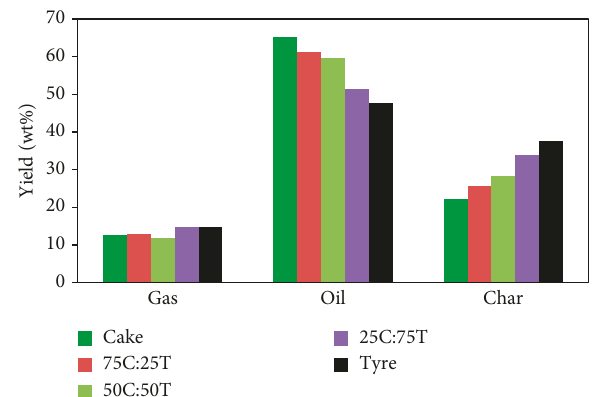
Figure 2: Experimental product yields performed at 500 ° C.